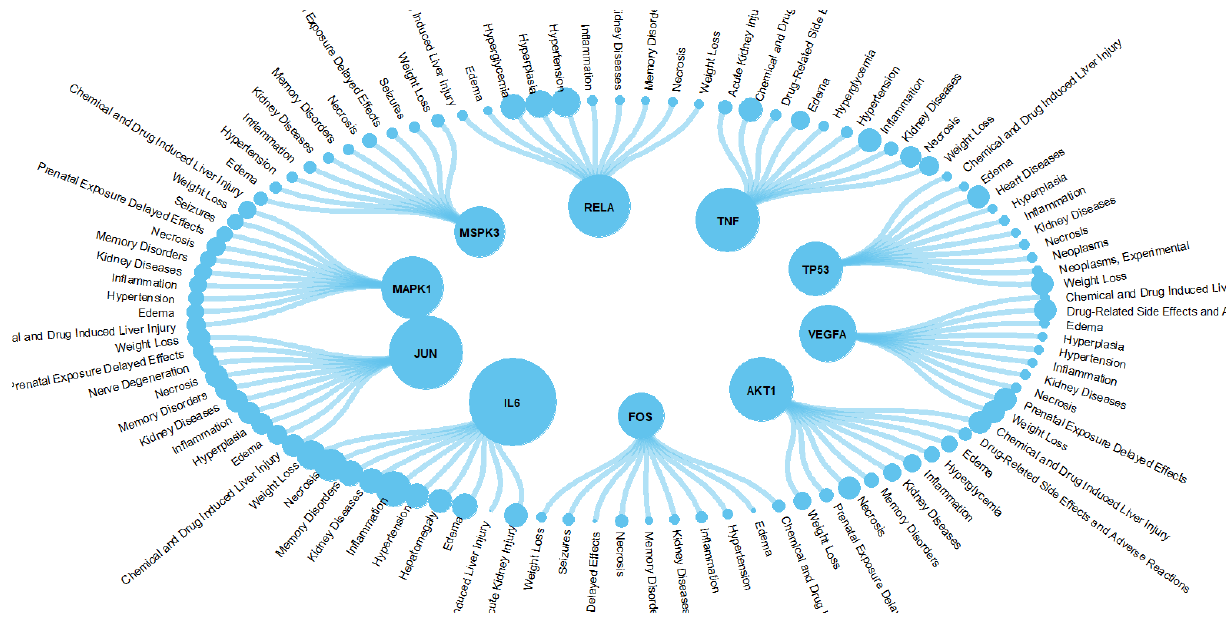
Figure 5. Top 10 hub genes associated with the gene-related diseases.